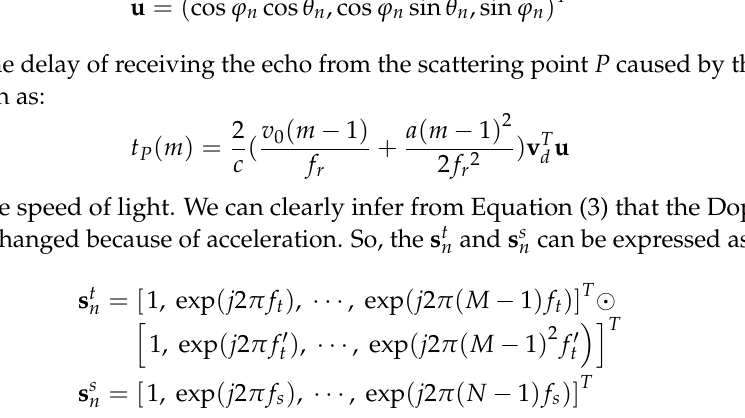
Then, the delay of receiving the echo from the scattering point P caused by the m − th pulse is given as: